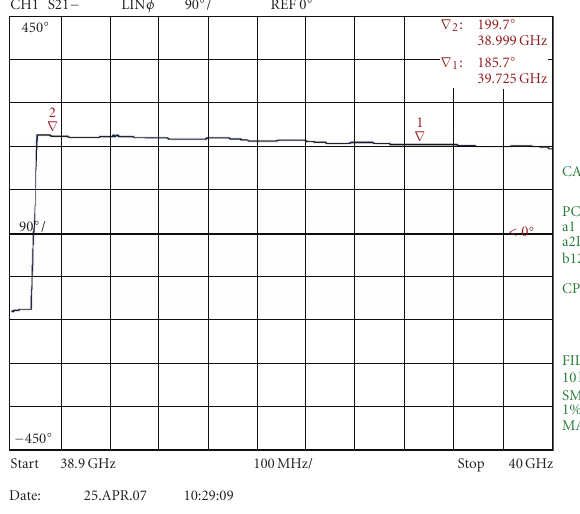
Figure 5: Phase shift between the two switching states of the bal- anced BPSK